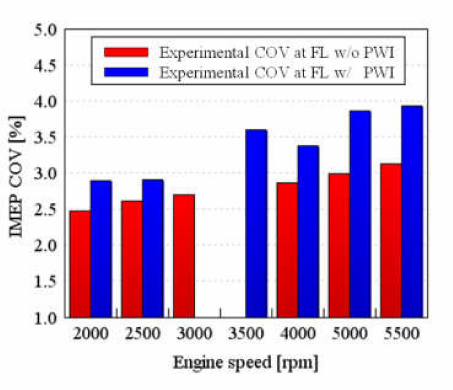
Figure 12. Experimental Coe ffi cient of Variation of the Indicated Mean E ff ective Pressure at Full-Load in dry (red bars) and wet (blue bars)